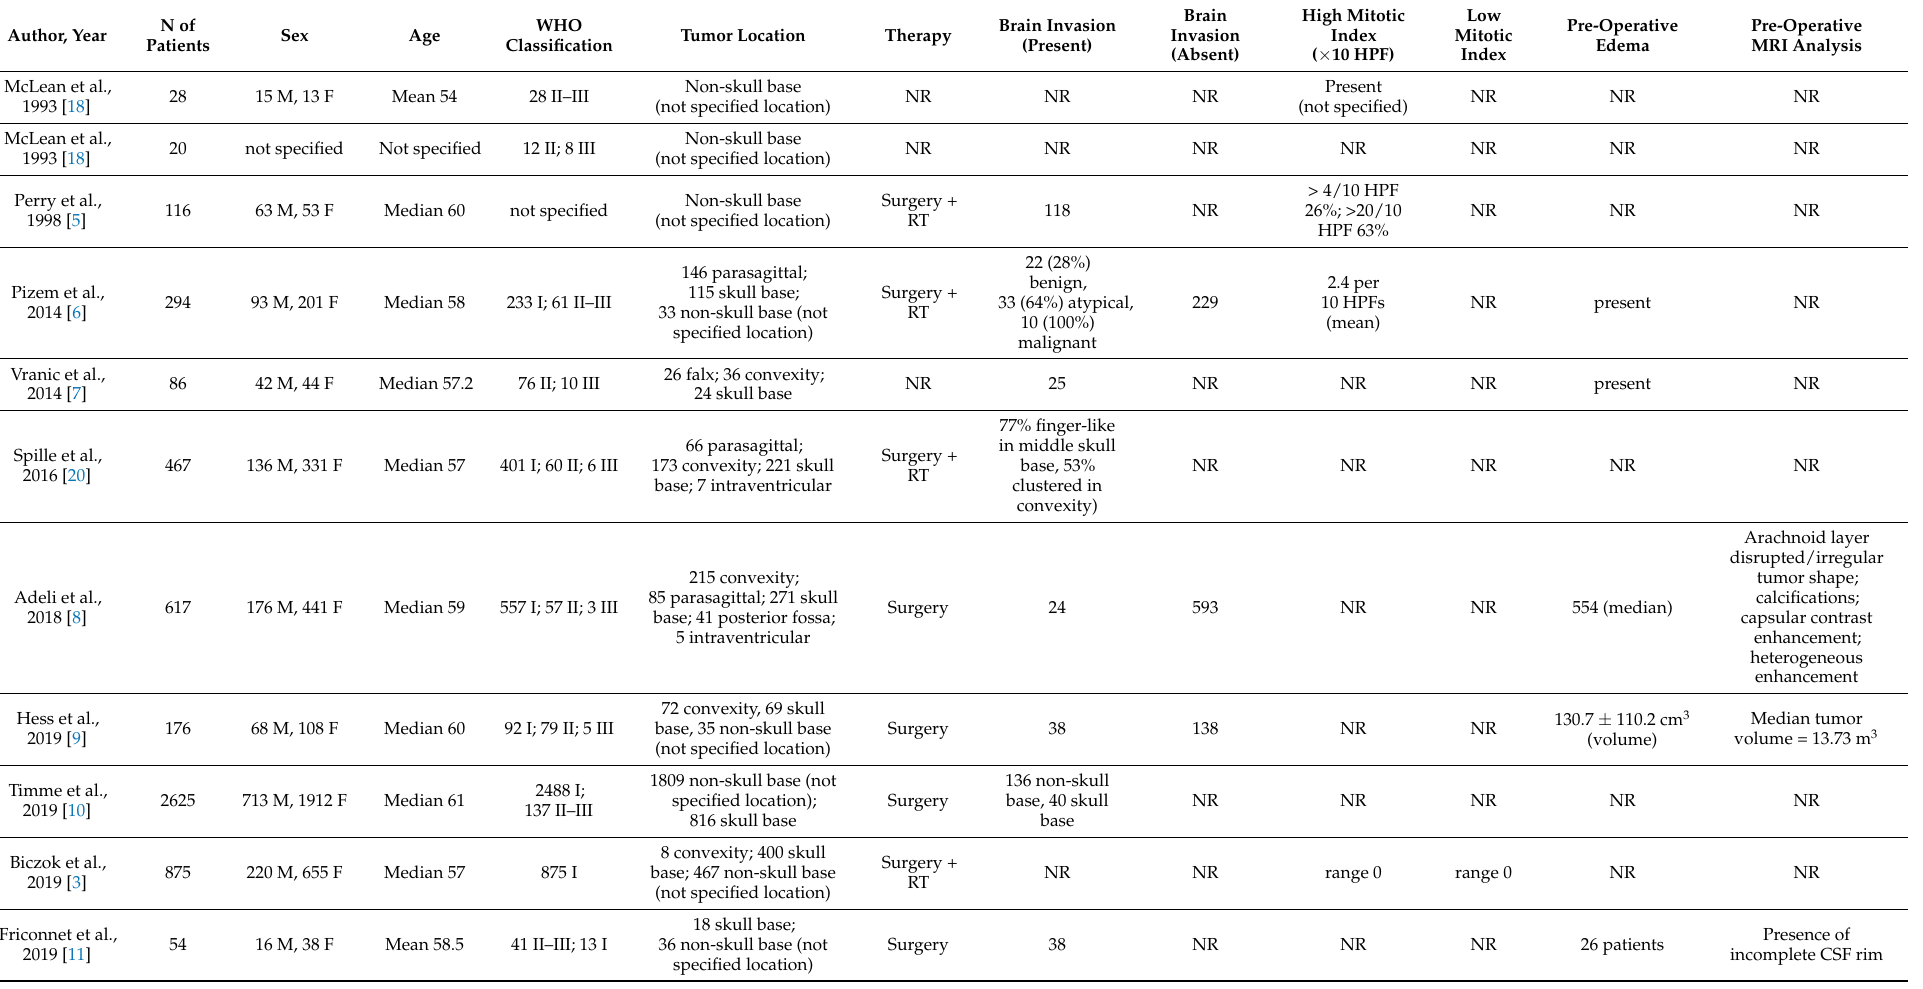
Table 1. Qualitative analysis of the main characteristic of the articles included in this systematic